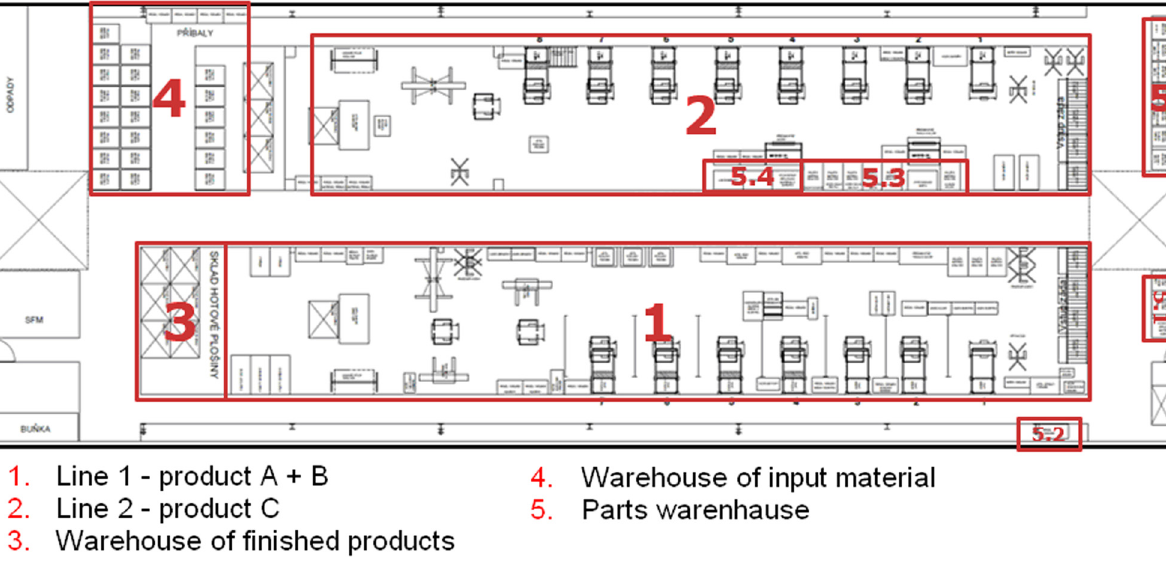
Figure 6: Design of working place